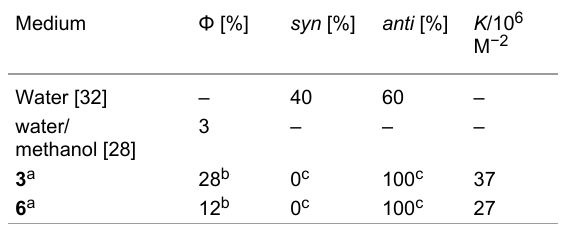
Table 2: Quantum yields Φ , distributions of the photodimers, and binding constants K [25] of ACE for various reaction medi a .